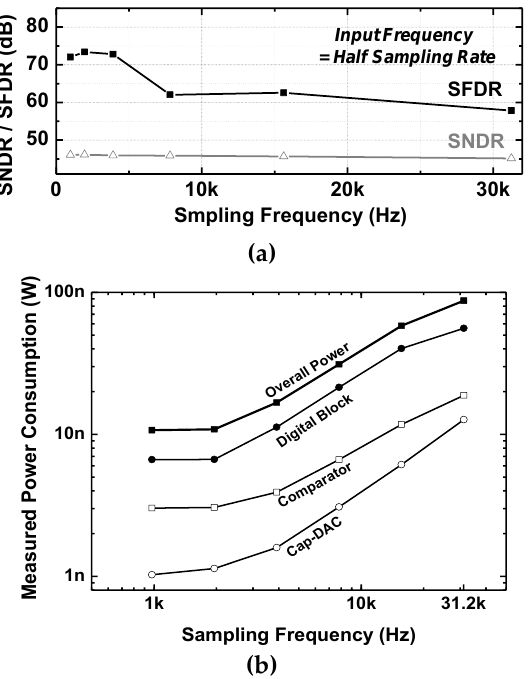
Figure 17. Measured SAR ADC characteristics: ( a ) SNDR/SFDR for various input and sampling frequency and ( b ) power consumption of the component blocks in the SAR ADC for 0.5 V rail-to-rail operation.